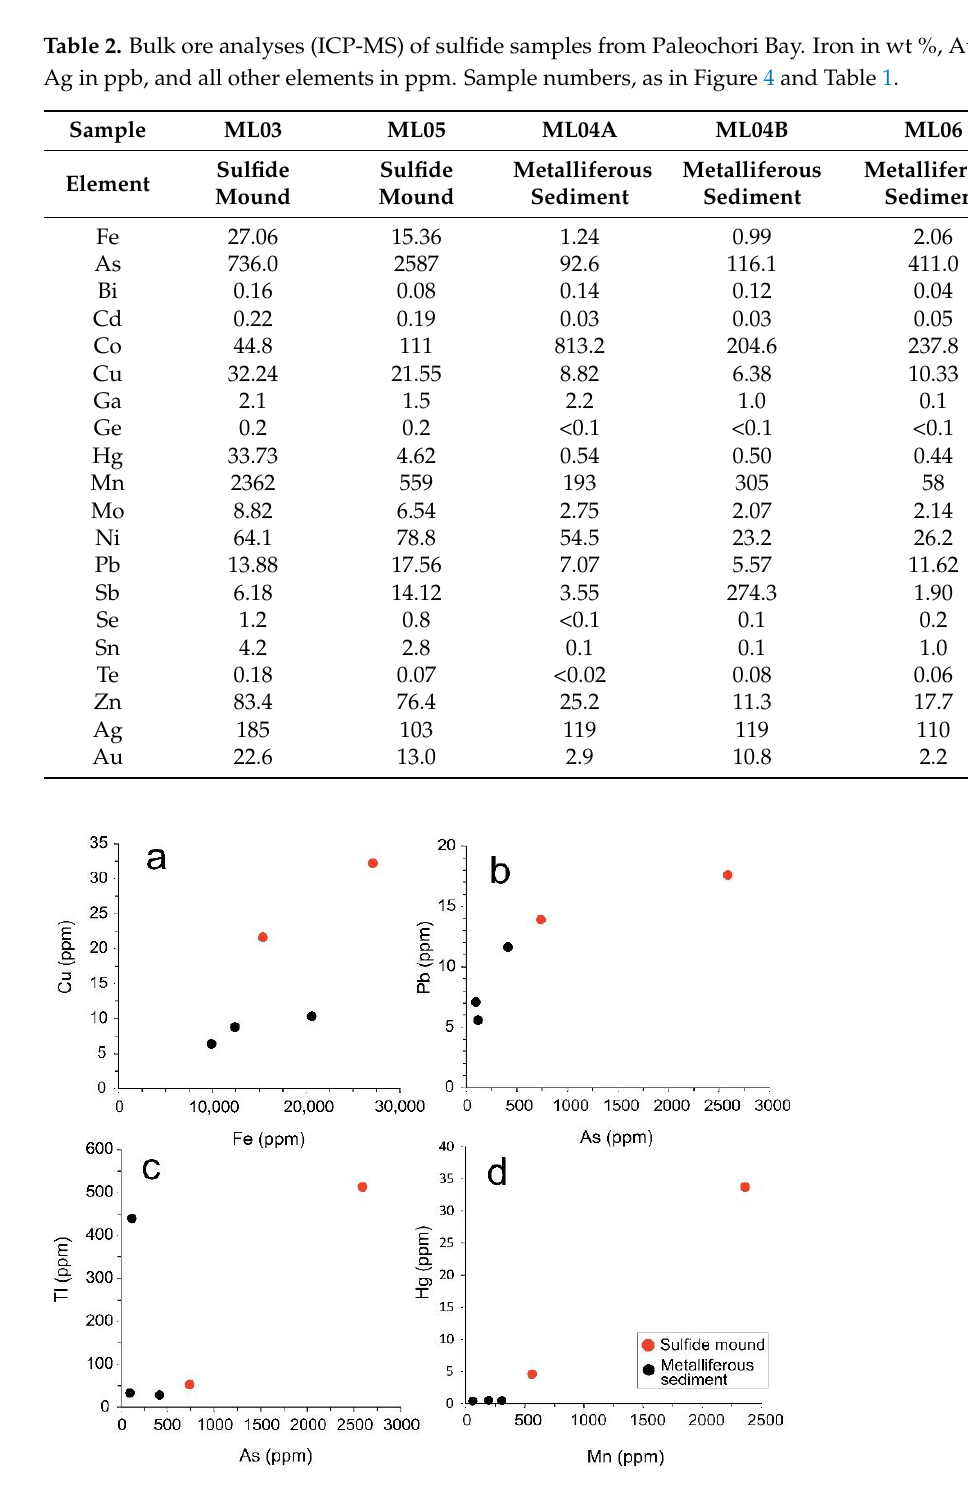
Figure 5. Bulk ore correlation diagrams of mineralized samples from Paleochori Bay: ( a ) Fe‐Cu; ( b ) As‐Pb; ( c ) As‐Tl; ( d ) Mn‐Hg.